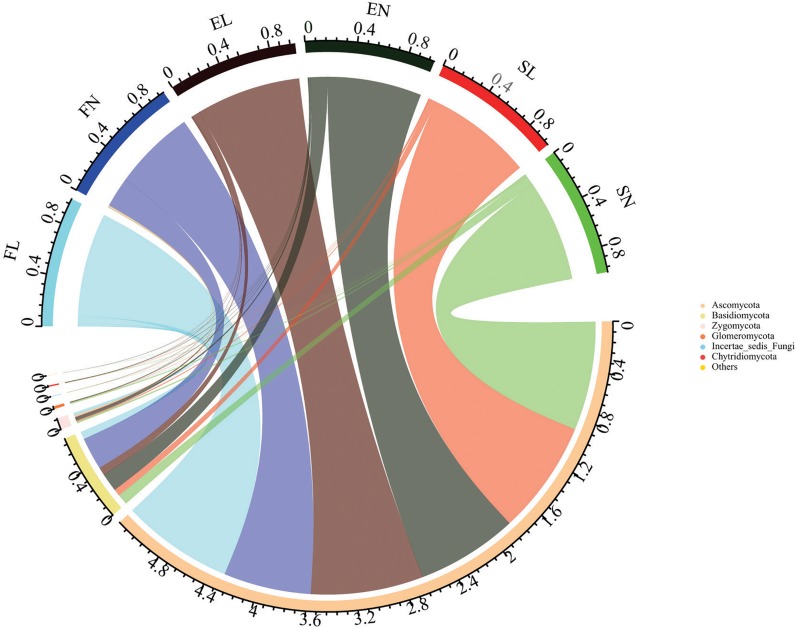
Composition of Fungal community at phylum level. The top six fungal phyla are shown, and the other phyla are included as “Others.” FL, black locust in forest habitat; FN, native plants in forest habitat; EL, black locust in forest-steppe habitat; EN, native plants in forest-steppe habitat; SL, black locust in steppe habitat; SN, native plants in steppe habitat.